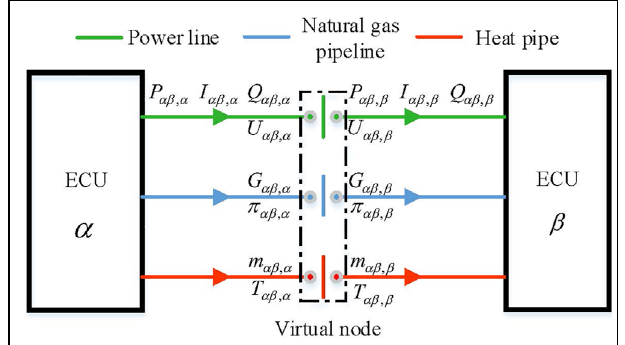
FIGURE 6 | Consensus variables between the ECUs.